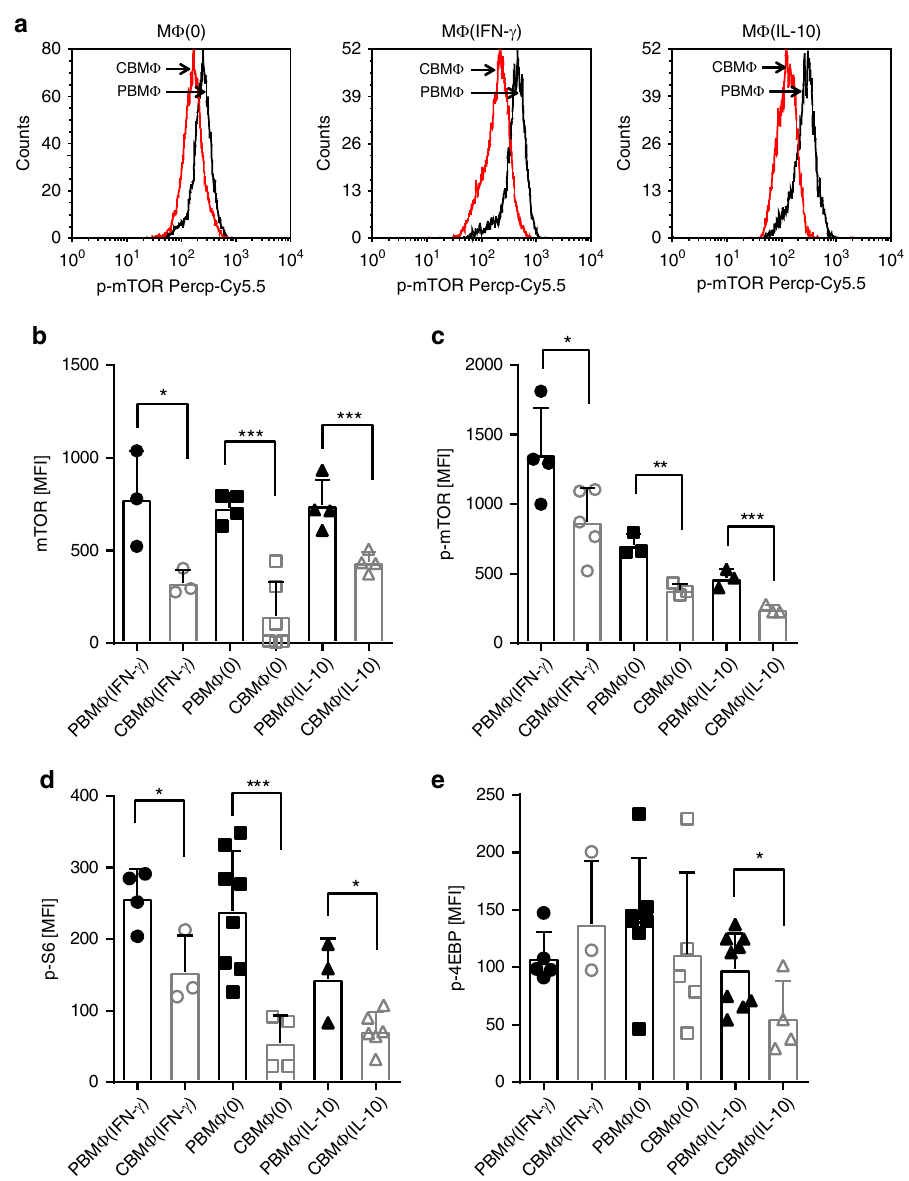
Fig. 4 Cord-blood macrophages reveal a reduced activation of the mTOR pathway. Representative histograms showing ( a ) mean fl uorescent intensity of p-mTOR expression in polarized CBM Φ (red) and PBM Φ (black). Statistics showing mean fl uorescent intensity of total mTOR expression ( b ; N = 3 – 6), p-mTOR expression ( c ; N = 3 – 5), mTOR target genes pS6 ( d ), and p4-EBP ( e ; N = 3 – 10) in polarized CBM Φ (gray-framed bars) and PBM Φ (black-framed bars; * p < 0.05; ** p < 0.01; *** p < 0.005), for statistics see supplemental